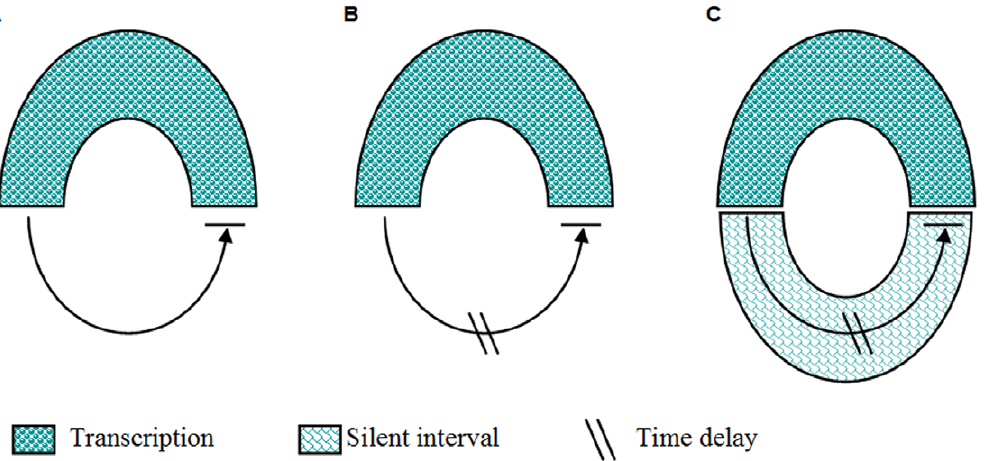
Figure 3. Different types of one-variable Goodwin model. A. Goodwin model with regular timescale. B. Goodwin oscillator with explicit time delay. C. The fractional delay Goodwin oscillator described by Eq. (17). The silent interval hinders the product to trigger the reinitiation of gene transcription and hence the time span of the silent interval is equal to the delay time.